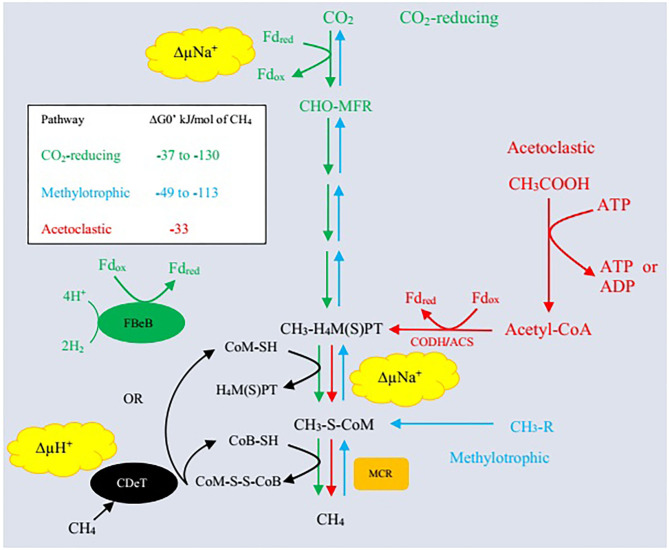
Three enzymatic pathways of methanogenesis. Δ, CO2-reducing pathway (hydrogenotrophic pathway); Δ, acetoclastic pathway; Δ, methylotrophic pathway; MFR, methanofuran; H4MPT, tetrahydromethanopterin; H4SPT, tetrahydrosarcinapterin; ΔG0′, standard free energy change; CH3-R, methyl-containing compounds such as methanol, methanethiol, dimethylsulfide, monomethylamine, dimethylamine, trimethylamine, and tetramethylammonium; Fdred, reduced form of ferredoxin; Fdox, oxidized form of ferredoxin; ΔμNa+, electrochemical sodium ion potential; ΔμH+, electrochemical proton potential; FBeB, flavin-based electron bifurcation; CDeT, cytochrome-dependent electron transfer; MCR, methyl-coenzyme M reductase; CODH/ACS, carbon monoxide dehydrogenase/acetylCoA synthase/decarbonlyase complex. Adapted from Lyu et al. (72).